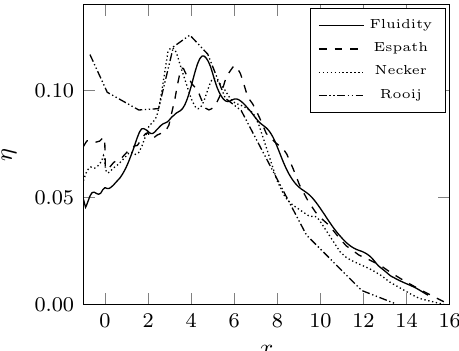
Figure 13. Span-wise averaged deposit profile from the three- dimensional simulation at t = 60. Comparisons are made against numerical results of Necker et al. (2002) and Espath et al. (2014) and experimental results of De Rooij and Dalziel